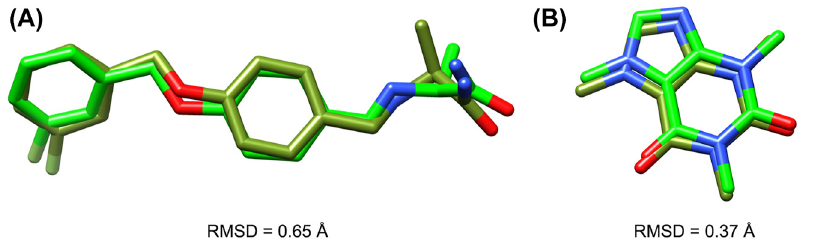
Figure 5: (A) Superposition and RMSD of crystal (green) and docked (olive green) structure of safinamide. (B) Superposition and RMSD of crystal (green) and docked (olive green) structure of caffeine.